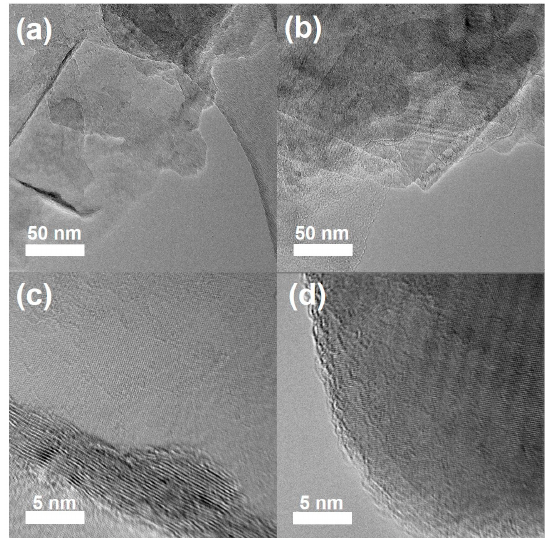
Figure 5. TEM images of ( a ) BNNSs and ( b ) BNNSs-OH@500. HRTEM images of ( c ) BNNSs and ( d ) BNNSs-OH@500.